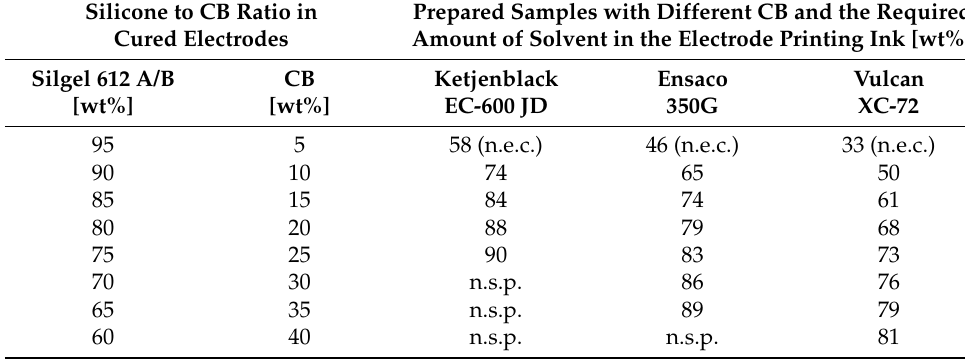
Table 3. Manufactured samples for first experimental section: Left: changing CB to silicone ratios; Right: used CB and the required amount of solvent for each electrode composition. Material composi- tions which showed no electrical conductivity are marked as n.e.c. = no electrical conductivity (could be achieved) while compositions which were not screen-printable anymore are marked as n.s.p. (not